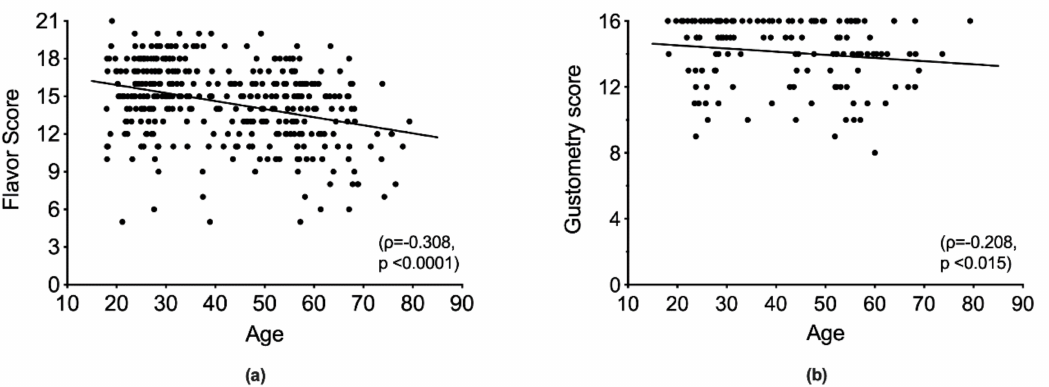
Figure 1. The e ff ect of age on flavor score ( a ) and gustometry ( b ). Age was inversely correlated with both the flavor score ( p < 0.0001) and gustometry score ( p =